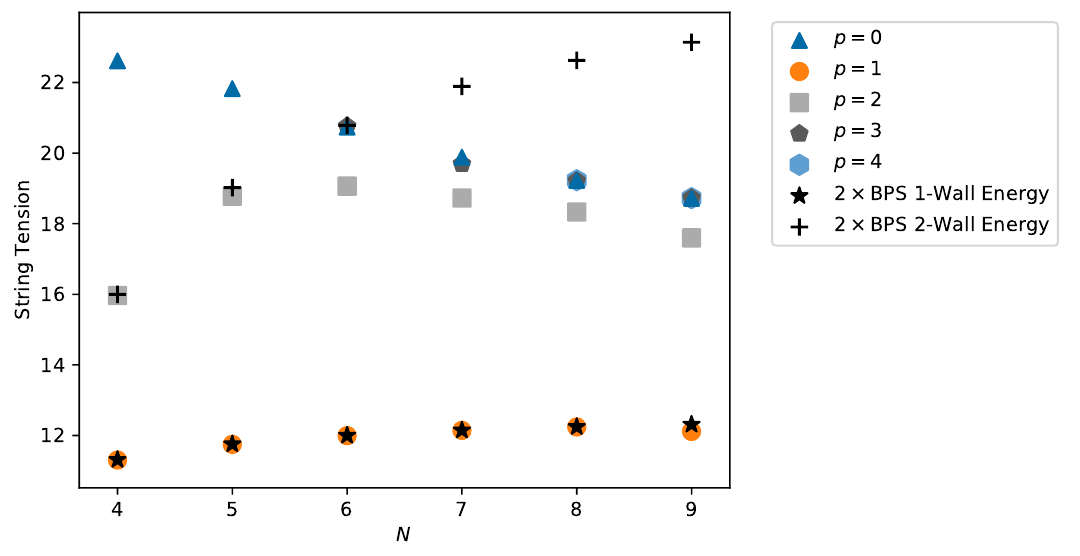
Figure 20. Approximate string tensions for weights in differing Z N orbits of N -ality k = 2 . The weight of each point is ν 1 , 1+ p = ν 1 + ν 1+ p . Also marked are twice the BPS 1-wall and 2-wall tensions for each N . The lowest tension orbit belongs to the highest weight, ν 1 , 2 = w 2 , and aligns closely with the tension of two BPS 1-walls. Notably, orbits with p > 1 and N > 5 appear to form a bound state with string tension lower than twice the BPS 2-wall tension, despite the expected double-string configuration for these weights being composed of 2-walls. This may be related to the N -ality k = 1 collapsing effect which led to the single-string